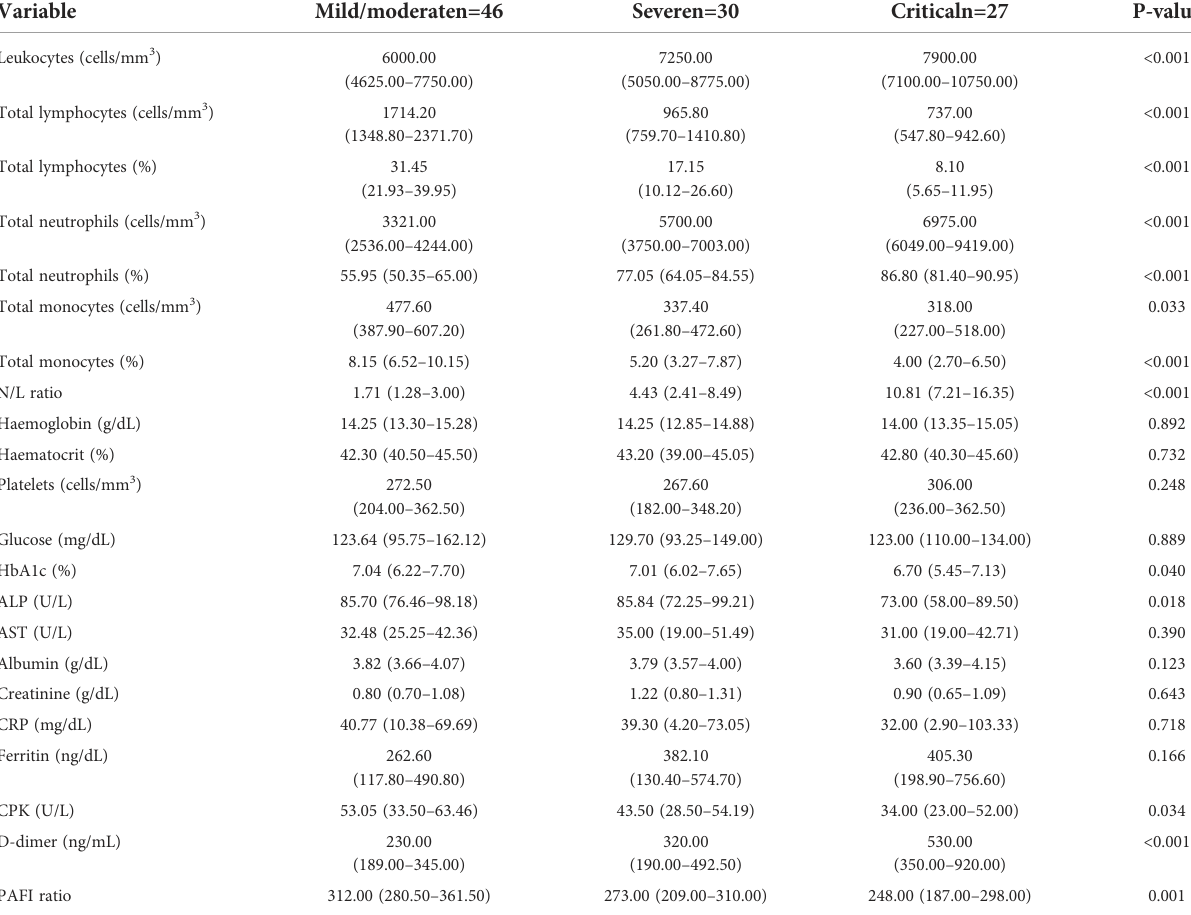
TABLE 2 Laboratory characteristics of patients with mild to critical COVID-19 at